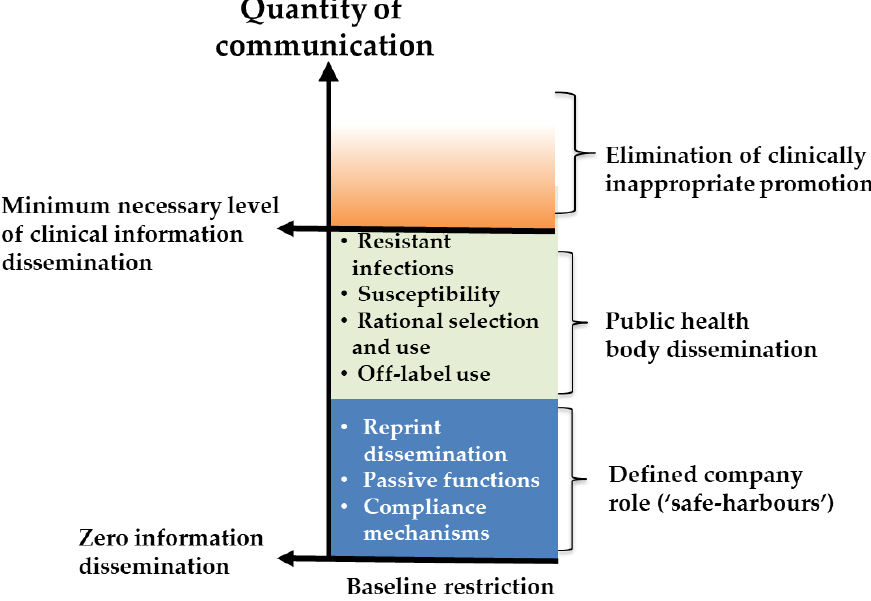
Figure 1. Conceptual representation of proposal for defining more appropriate boundaries for company marketing and promotion of a novel antibiotic.